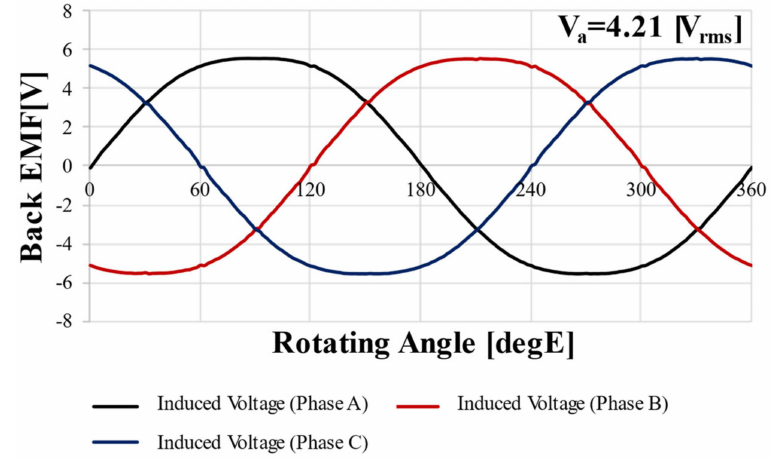
Figure 11. Back EMF FEA result for AFPM motor @1000 rpm.